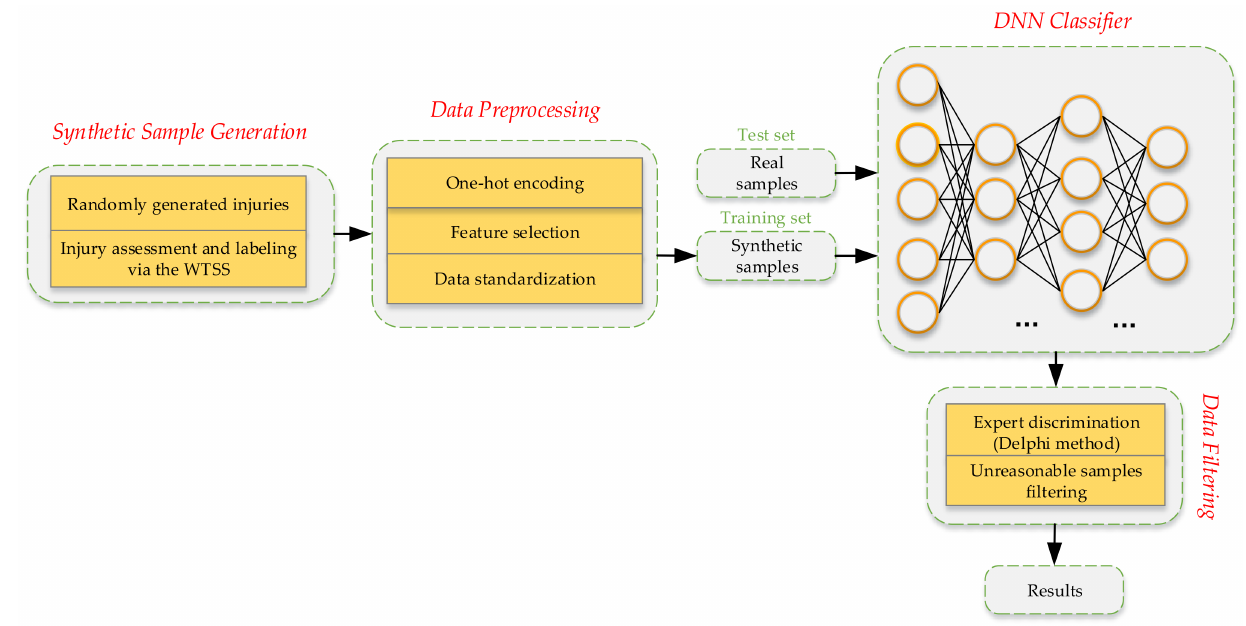
Figure 1. Workflow of the WTSS–DNN integrated